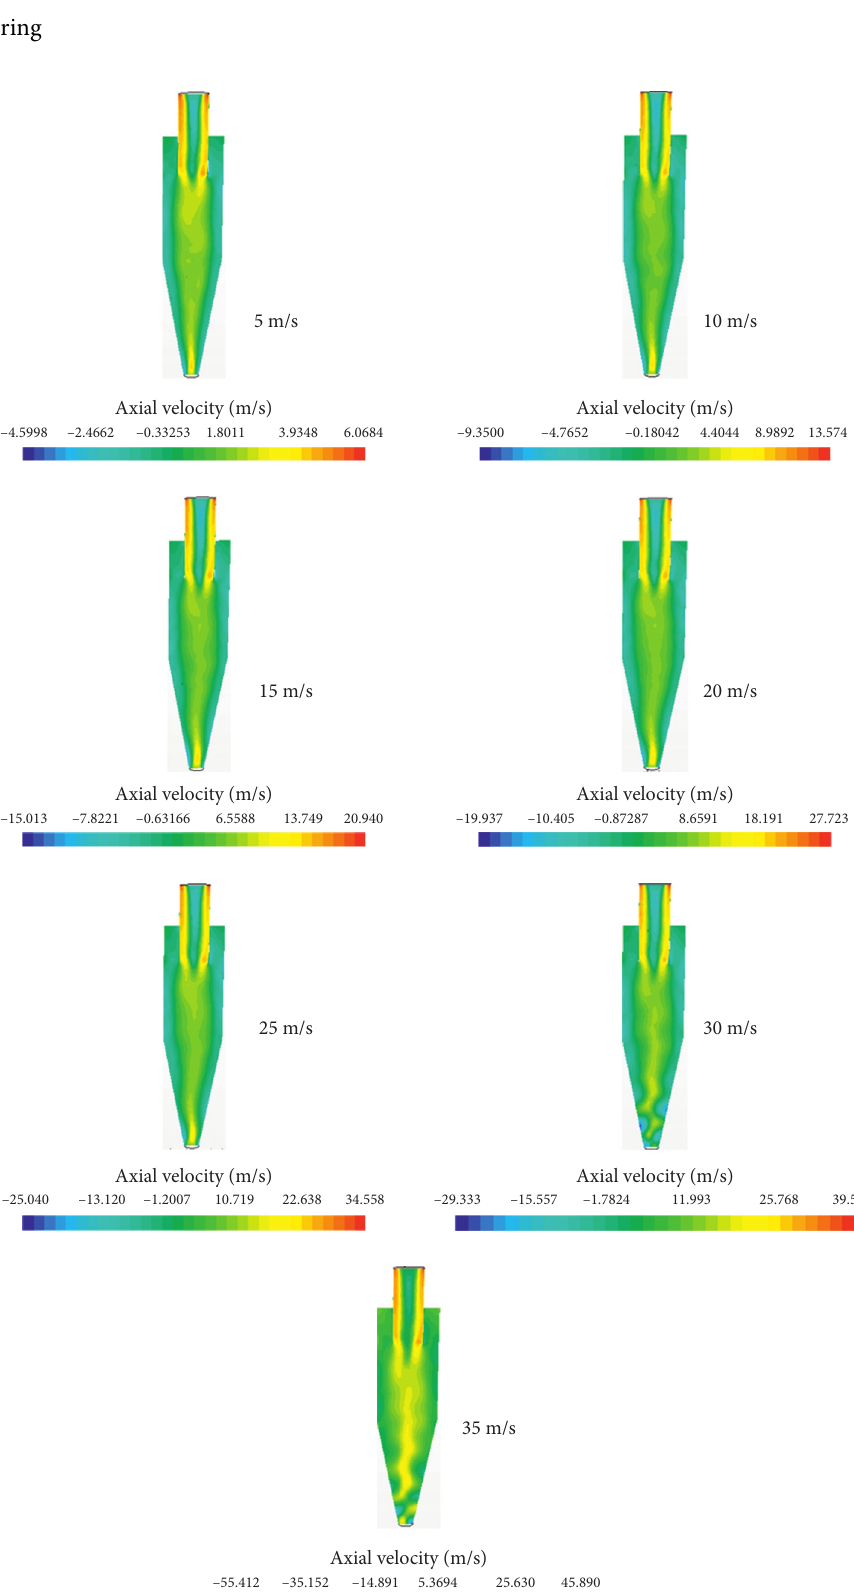
Figure 7: Axial velocity contours with different inlet